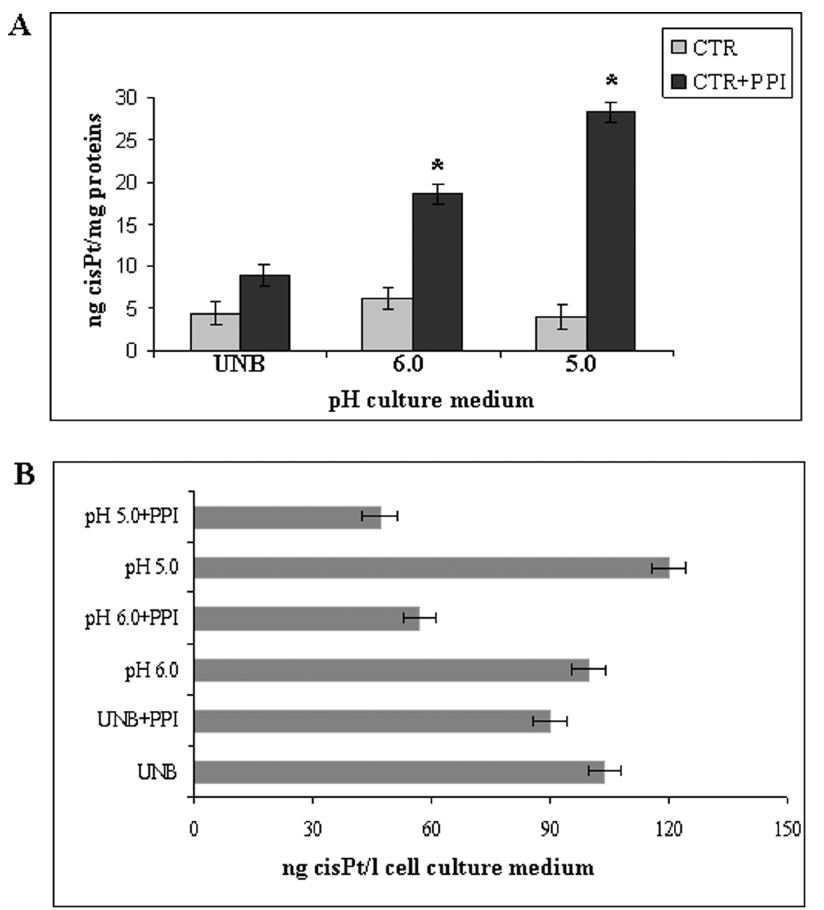
Figure 3. Effect of PPI on CisPt cellular uptake. A: Effect of PPI on CisPt uptake in Me30966 cells in function of different pH (UNB, 6.0 and 5.0) culture medium. CTR: Me30966 cells incubated with CisPt, without PPI pre-treatment; CTR + PPI: Me30966 cells pretreated with PPI and then incubated with CisPt. Significance (p , 0.05) refers to CisPt cellular uptake at 5.0 and 6.0 pH in comparing PPI pretreatment to CTR in UNB medium. B: Effect of PPI on drug release at different pH (UNB, 6.0 and 5.0). CisPt ng/l present in cell culture medium obtained from cells pretreated with PPI and then incubated with CisPt. p , 0.05. Representative of three independent experiments are reported.